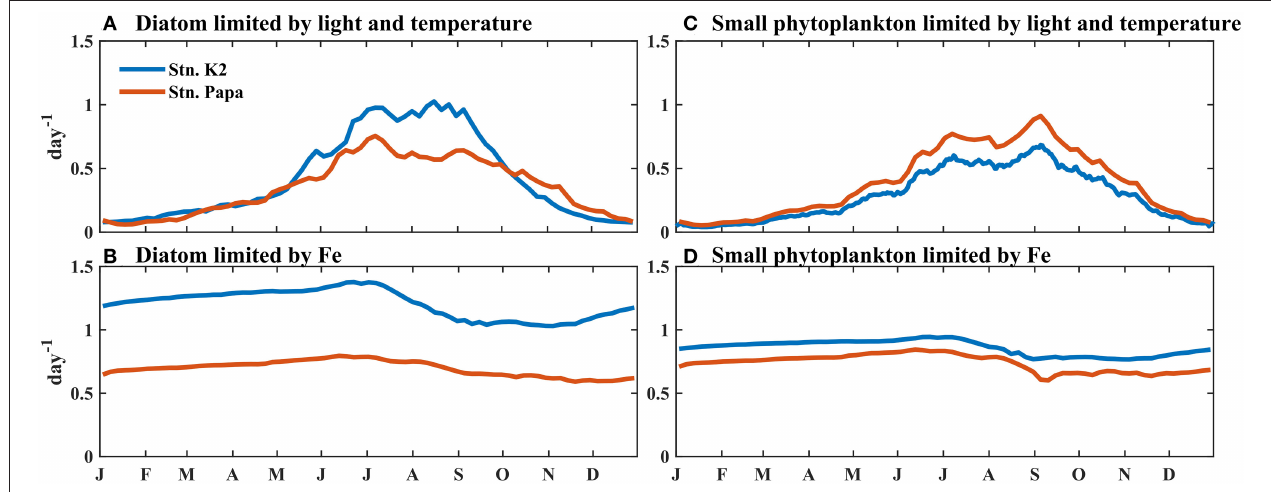
FIGURE 8 | Modeled vertically integrated growth rate as limited by (A,C) light and temperature and (B,D) Fe for (A,B) diatoms and (C,D) small phytoplankton, weighted by the phytoplankton biomass. Note that the phytoplankton growth rate is limited only by (A,C) light and temperature, but Fe limitation is not considered; (B,D) are limited only by Fe, but temperature and light limitation are not considered.